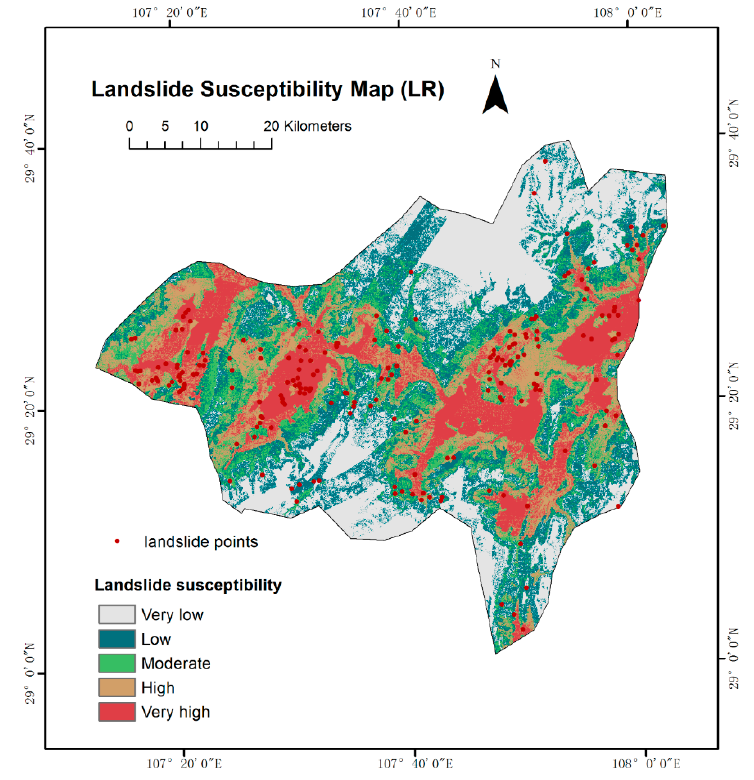
Figure 6. Landslide susceptibility map for the LR model.